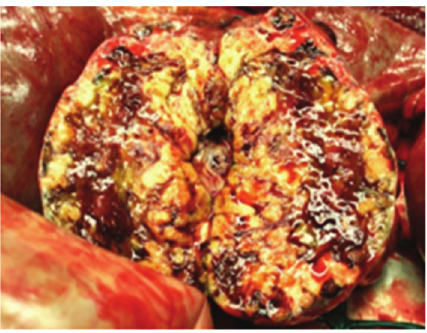
Figure 2: Cross-section: brittle consistency, red-beige mottled with multifocal